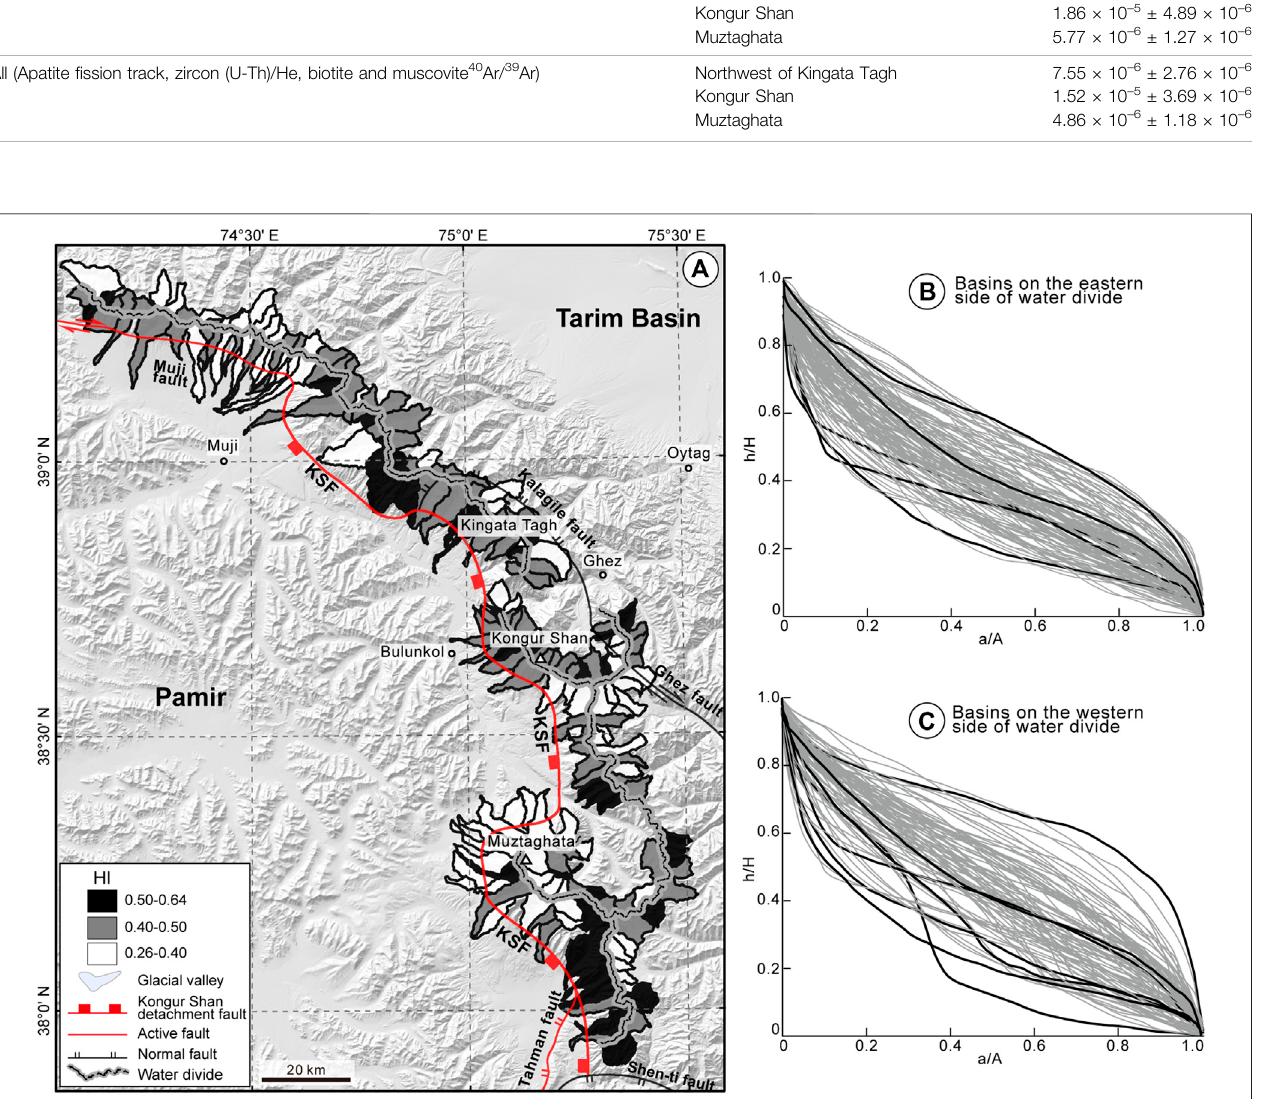
Frontiers in Earth Science |